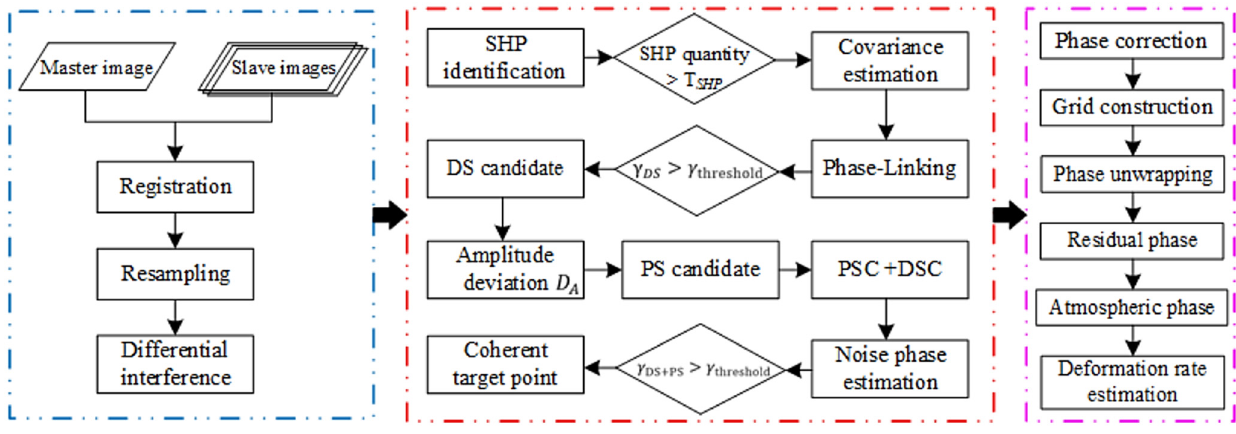
Figure 5. DS-InSAR data processing flow.